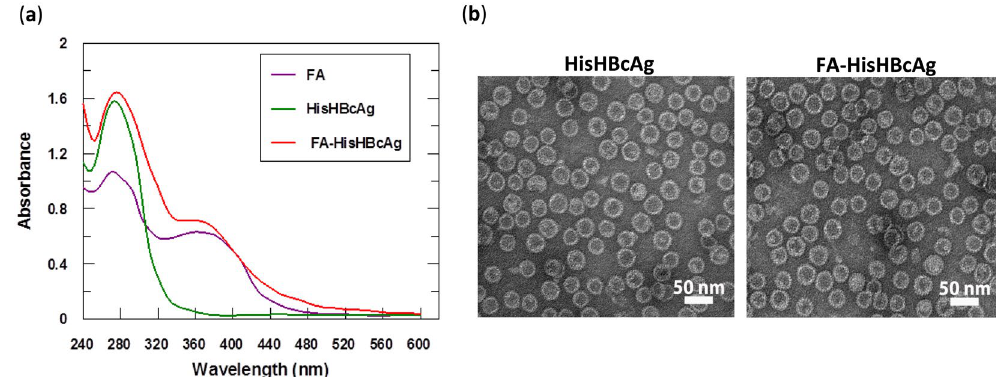
Figure 2. Conjugation of folic acid to His-tagged VLNPs. ( a ) Spectra of folic acid (FA), HisHBcAg nanoparticles (HisHBcAg), and FA-conjugated HisHBcAg nanoparticles (FA-HisHBcAg). ( b ) Electron micrographs of HisHBcAg nanoparticles. The samples (as labelled on top of the micrographs) were stained with uranyl acetate and viewed under a TEM. All the samples assembled into spherical structures. White bars indicate 50